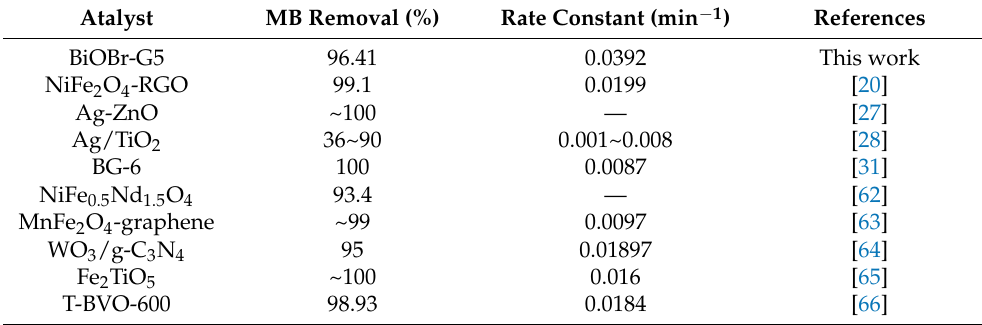
Table 1. MB removal rate and kinetic constant of various catalysts reported in previous studies.